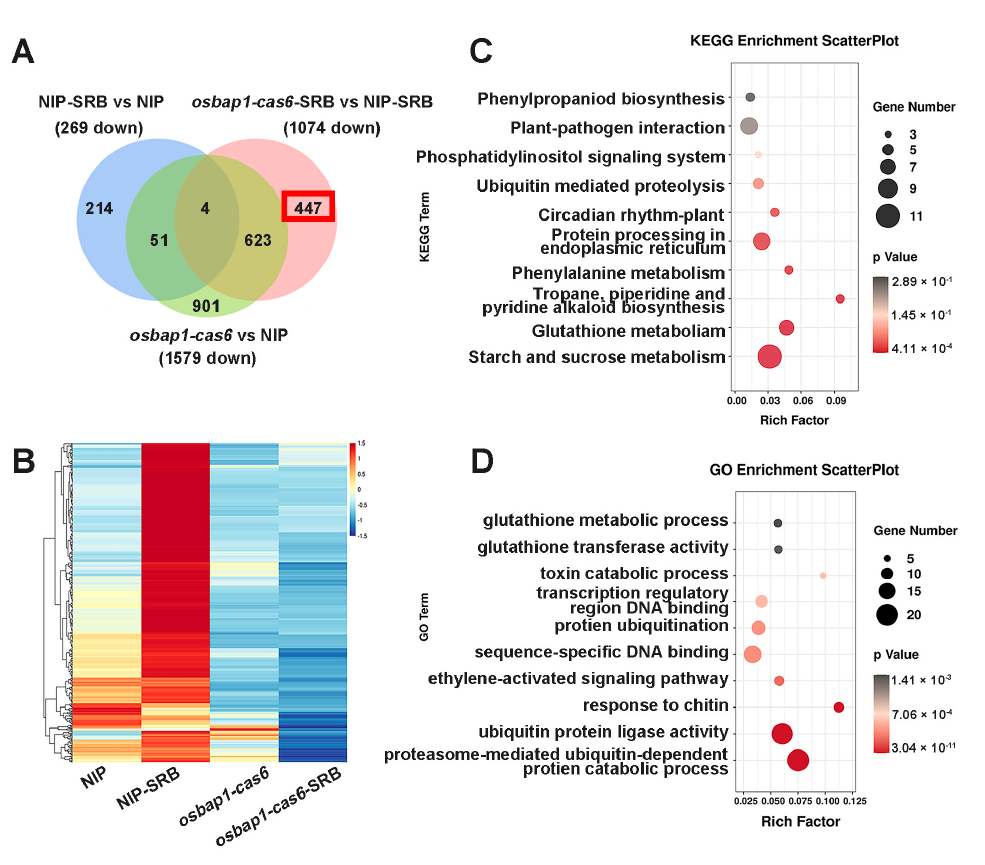
Figure 5. Analysis of the down-regulated genes associated with SRBSDV infection in osbap1 - cas6 mutant plants: ( A ) Venn diagram illustrating the overlapping of down-regulated 447 DEGs in NIP-SRB vs. NIP, osbap1 - cas6 -SRB vs. NIP-SRB, and osbap1 - cas6 vs. NIP. ( B ) Hierarchical clustering of 447 DEGs (A) based on the log 2 fold change in transcript levels in NIP and osbap1 - cas6 under mock or SRBSDV inoculation. ( C ) KEGG pathway enrichment analysis of 447-down genes (marked with a red rectangle) in ( A ). ( D ) Gene ontology (GO) enrichment analysis of 447-down genes (marked with a red rectangle) in ( A ). “Rich factor” shows the ratio between the number of DEGs and the total genes in this pathway. All differentially expressed genes were selected using the absolute value of log 2 (fold change) ratio ≥ 1 and p ≤ 0.05. Data were collected from three biological replicates, each containing a pool of three